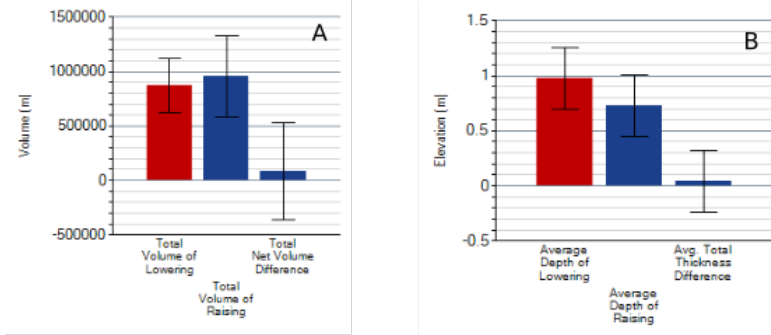
Figure 14. ( A ) Bar chart of DoD volume change distribution. ( B ) Bar chart of DoD elevation change